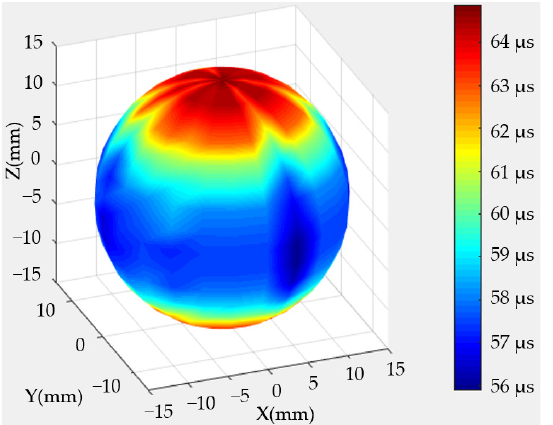
Figure 6. Arrival times of longitudinal waves on the basis of scanning-measurement endings.